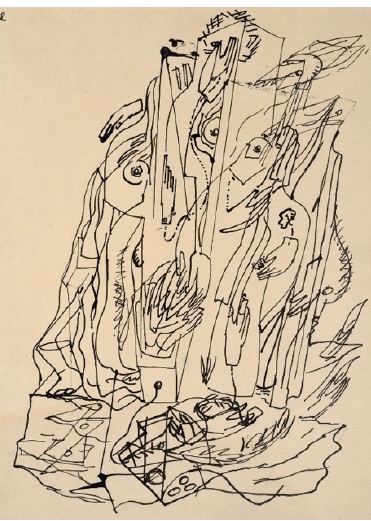
Figure 9. Automatic Drawing by André Masson (1924–1925). Ink on colored paper. Photo courtesy Galerie Natalie Seroussi and used by permission.